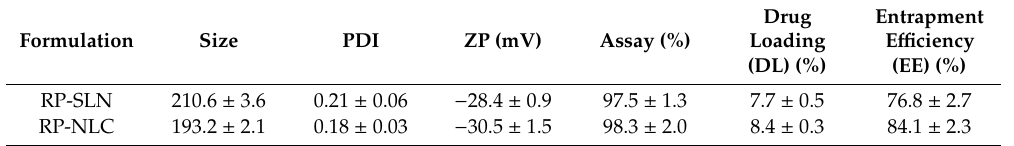
Table2. Particlesize, PolydispersityIndex(PDI),zetapotential(ZP),assay, drugloadingandentrapment e ffi ciency ropinirole loaded SLN and NLC formulations (mean ± SD, n = 3).